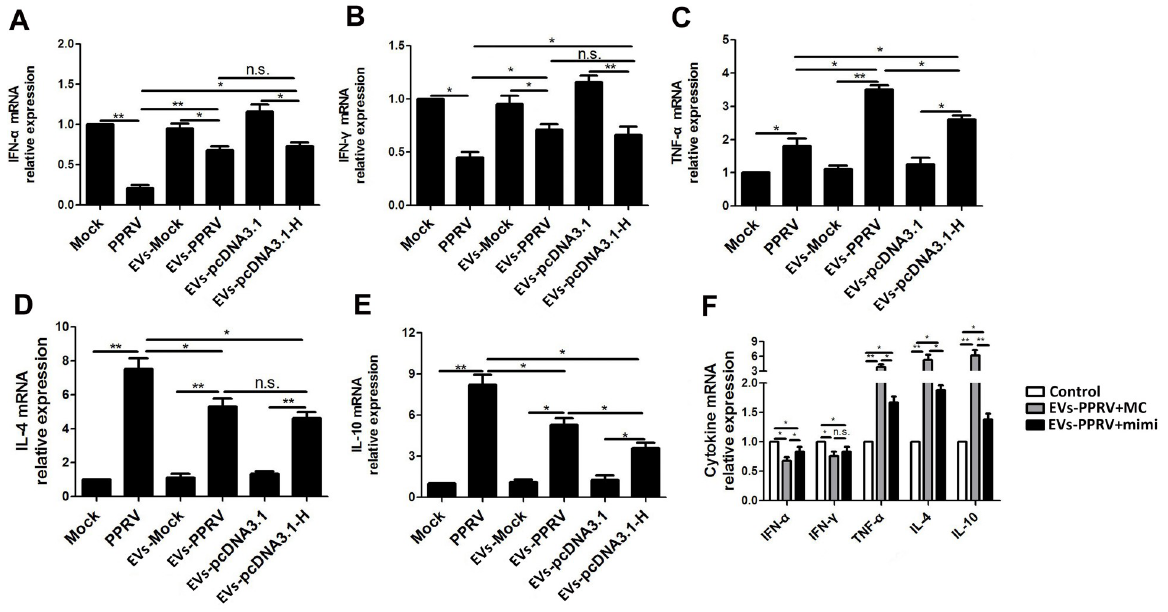
Fig 6. PPRV associate extracellular vesicles regulate SLAM mediated cytokines expression in the recipient cells. (A, B, C, D, E) Goat PBMCs were incubated with extracellular vesicles isolated from mock- (EVs-Mock), PPRV-infected cells (EVs-PPRV), or from cells transfected with pcDNA3.1-H (EVs-pcDNA3.1-H) or pcDNA3.1 control plasmid (EVs-pcDNA3.1). After 48 h, the cells were subjected to qRT-PCR for the analysis of the expression of IFN- α (A), IFN- γ (B), TNF- α (C), IL-4 (D), and IL-10 (E). PPRV-infected cells and Mock-infected cells were used as positive and negative control, respectively. (F) Goat PBMCs were transfected with miR-218 mimic (mimi) or mimic control (MC) for 24 h, and incubated with EVs-PPRV for 24 h. EVs-Mock incubated with untreated cells were used as control. Then, the cells were subjected to qRT-PCR for the analysis of the indicated cytokines expression. GAPDH was used as a loading control in qRT-PCR analysis. Data are given as means ± standard deviation (SD) from three independent experiments. P values were calculated using Student’s t test. An asterisk indicates a comparison with the indicated control. � , P < 0.05; �� , P < 0.01; n.s., not